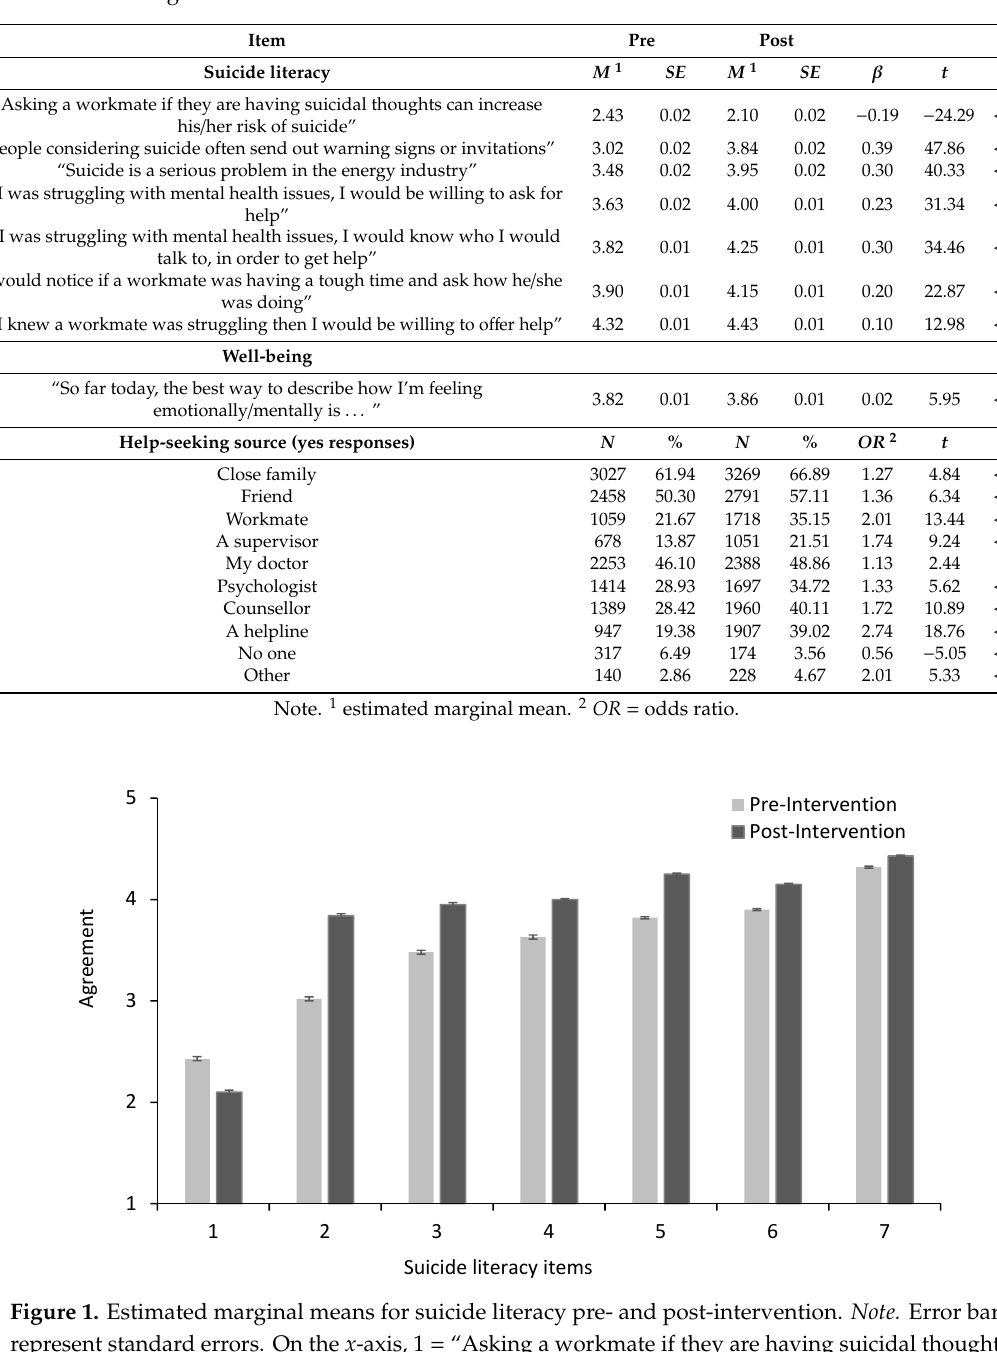
Table 1. Descriptive statistics and fixed e ff ect estimates for pre–post-GAT training from the linear mixed-e ff ects regression.